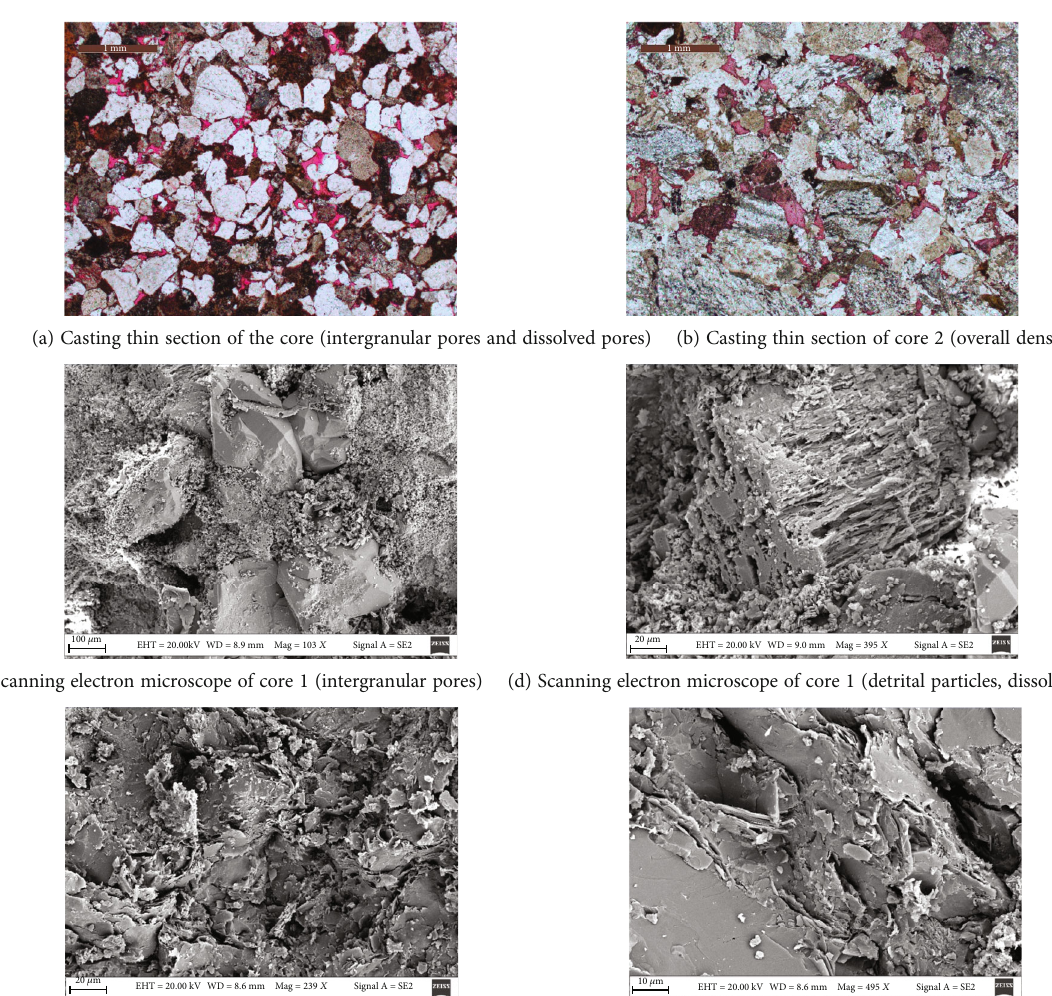
Figure 1: Cast thin section and scanning electron